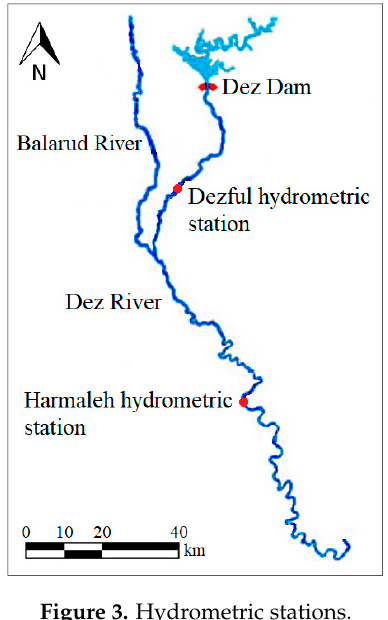
Figure 3. Hydrometric stations.